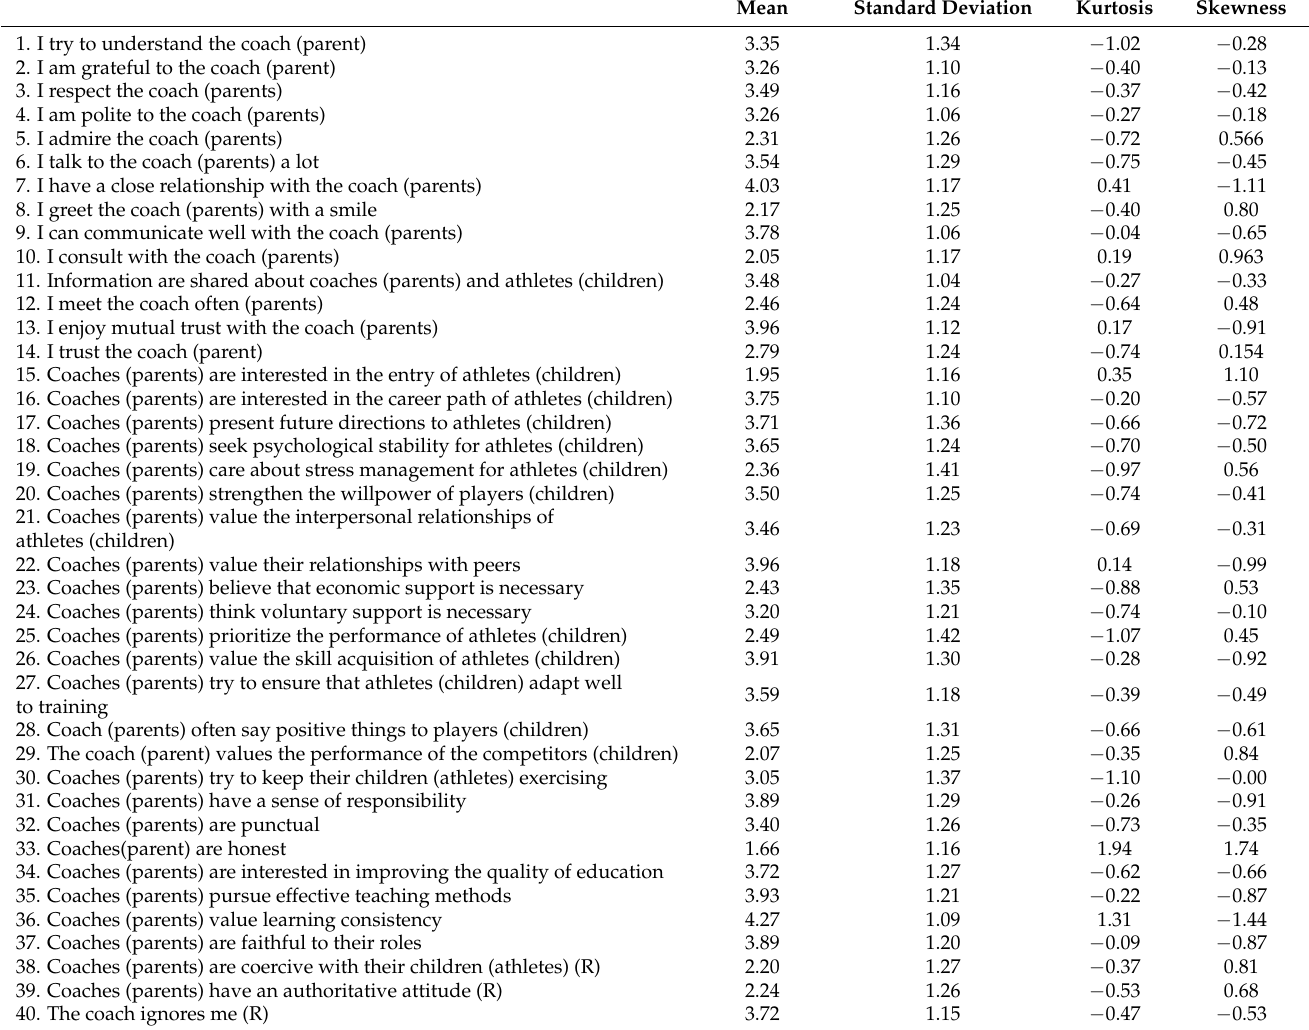
Table 1. Parent–coach interaction measuring tools preliminary items configuration and items analysis